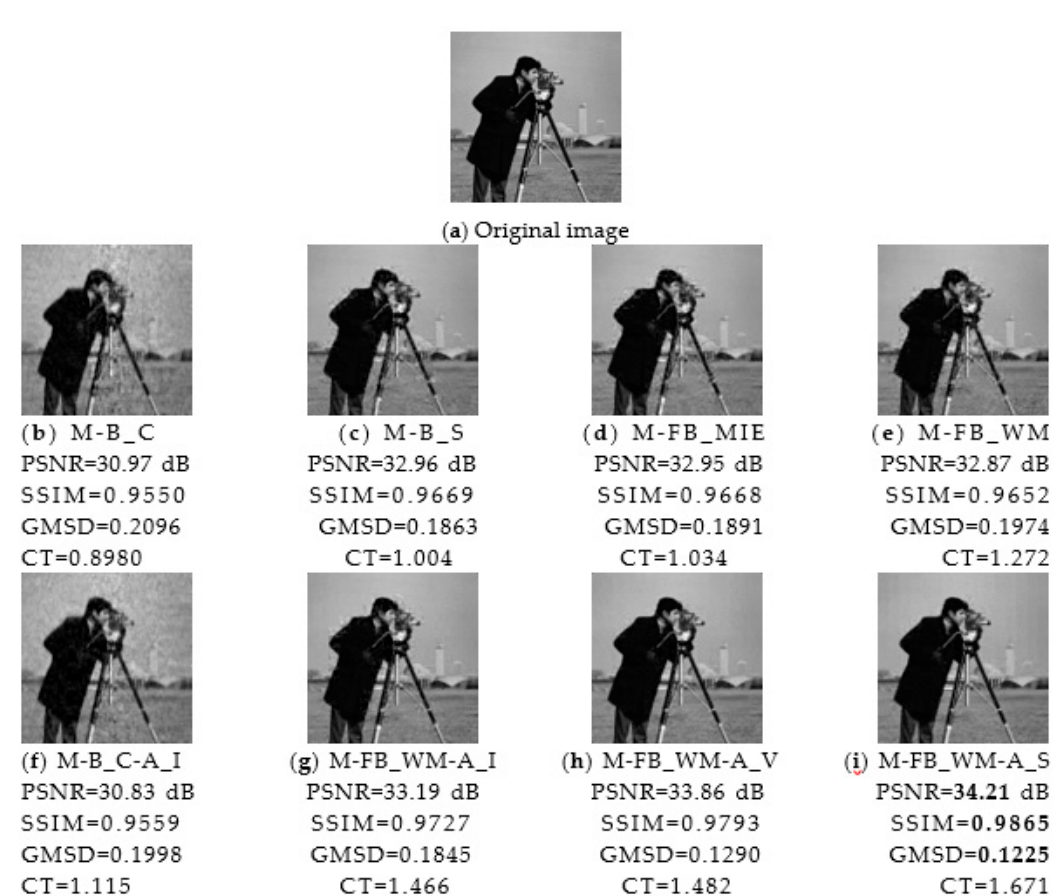
Figure 3. Reconstructed images of Cameraman and performance indicators with different BCS algorithms (TSR = 0.5). Table 2. The PSNR and SSIM of reconstructed images with eight BCS algorithms based on iteratively reweighted least square (IRLS) and basis pursuit (BP).